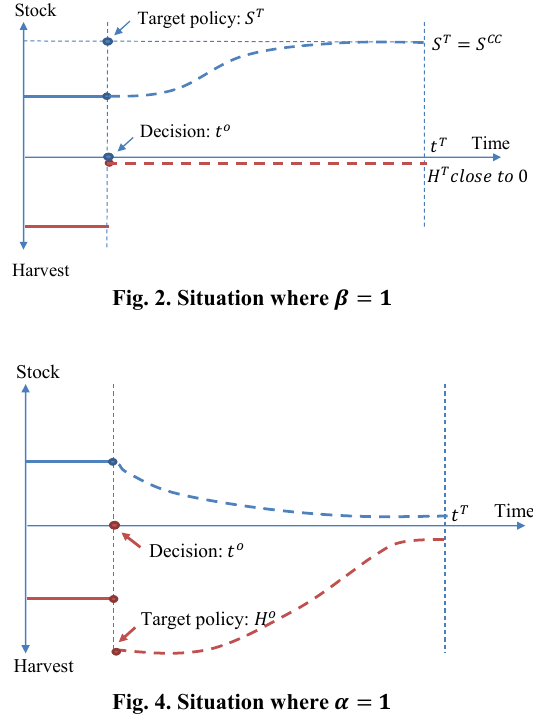
Fig. 3. Situation where